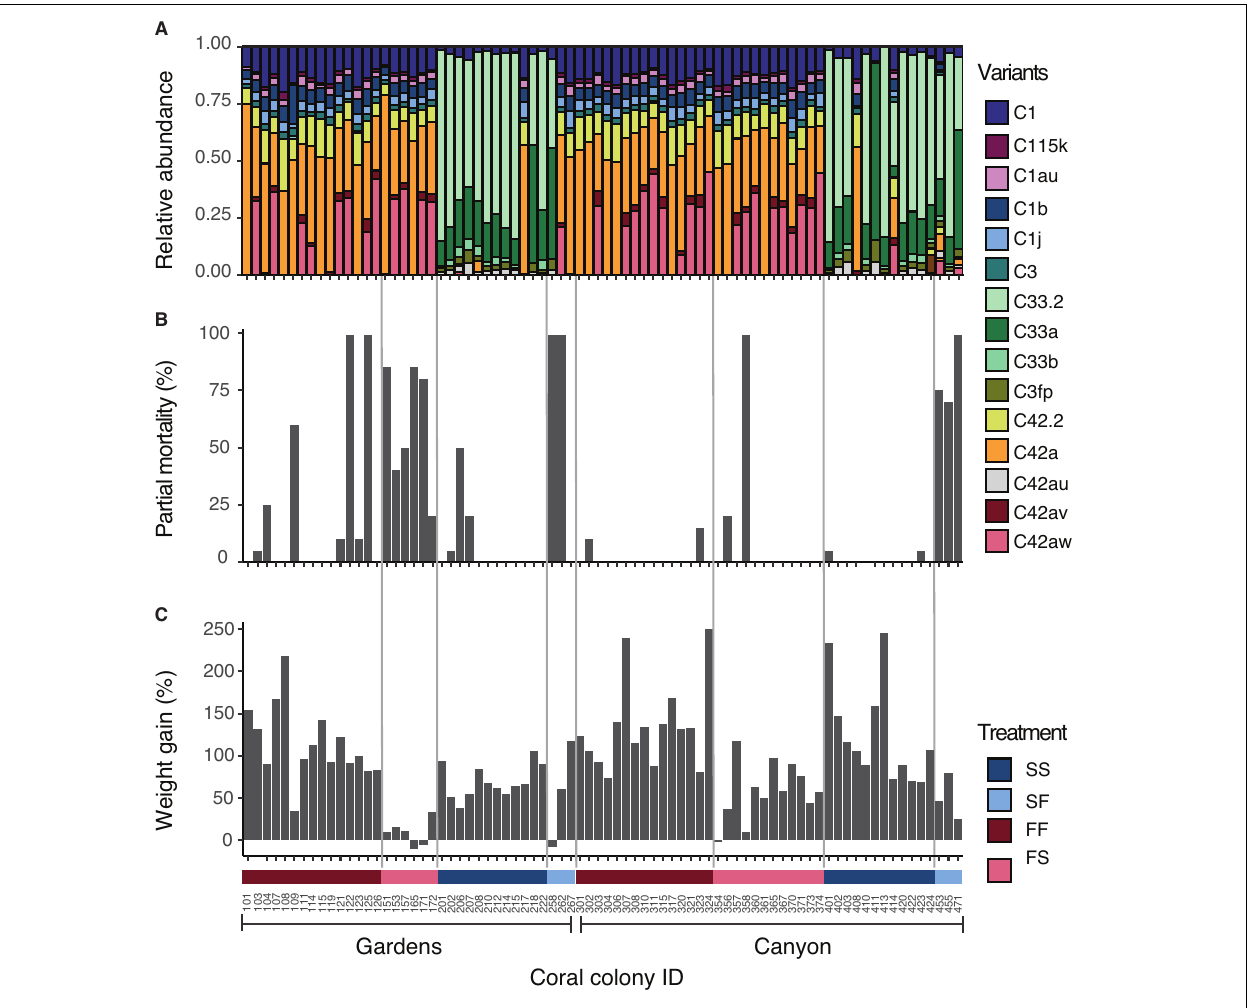
FIGURE 3 | Responses of individual coral colonies organized by site and treatment group after 12 months of reciprocal transplantation (March 2013). Numbers on the X -axis are colony ID and each ID number may correspond with a matching genet in the opposite habitat (i.e., FF ID 101 matches FS ID 151). All matching genetic pairs are listed in Supplementary Table 16 . (A) Symbiodiniaceae community in coral tissue. Each color denotes relative abundance of different ITS2 sequence variants present. (B) Percent partial colony mortality. (C) Percent cumulative weight gain. Positive numbers designate weight gain, negative numbers designate weight